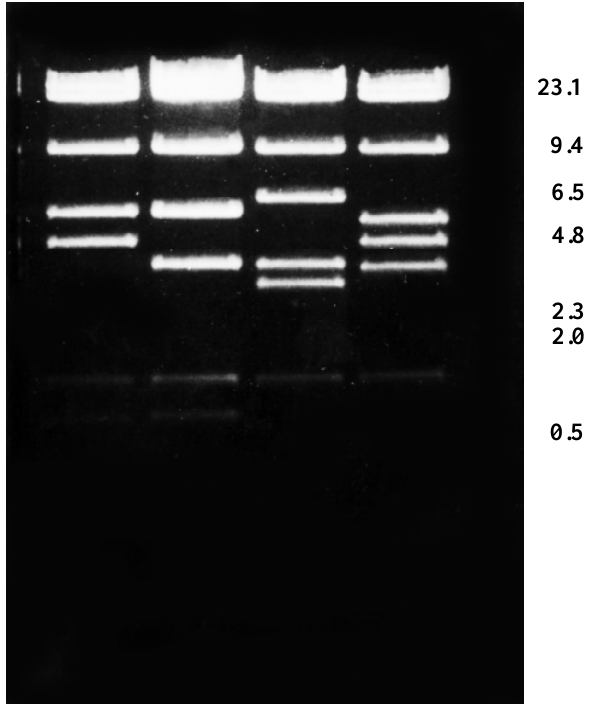
Figure 1 - Four recombinant phages (Dash-Stratagene) were grown us- ing Q359 as the host bacteria and DNAs purified as described in the text. Two m g of each phage was digested with ECOR1 (Boehringer) for one hour and separated in a 0.8% agarose gel using a Horizon 58 (Gibco- BRL) electroforesis apparatus. Bars indicate the positions of lambda/ Hin dIII